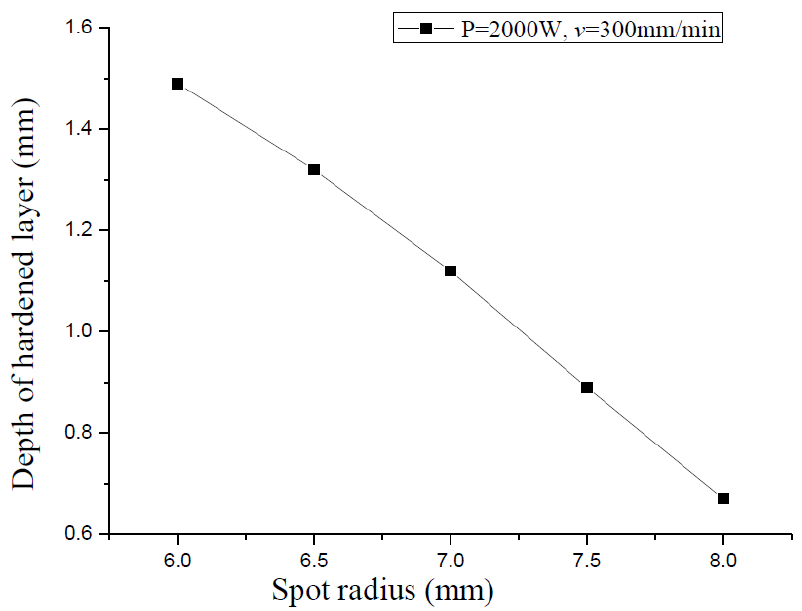
Figure 8. The relationship between different spot radius and hardened layer depth.